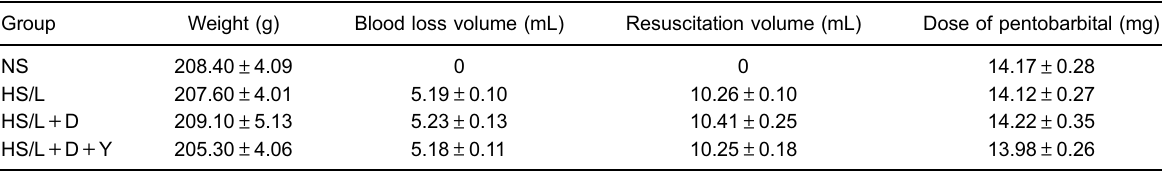
Table 1. Baseline